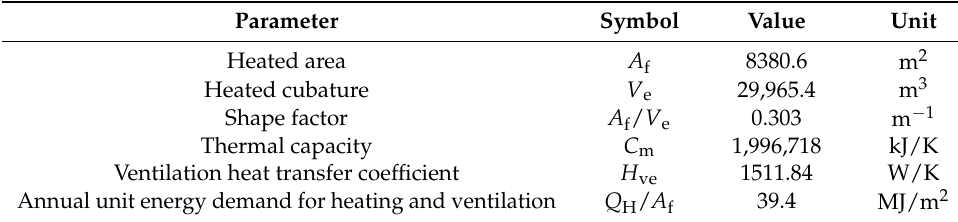
Table 2. Most important building parameter.